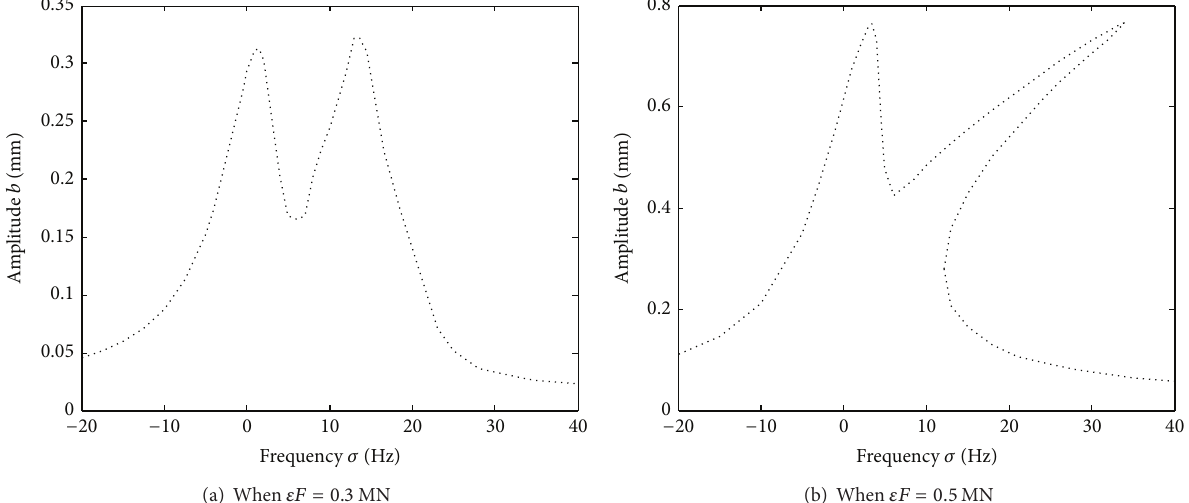
Figure 9: Curve of inner resonance amplitude frequency in vertical direction with disturb amplitude 𝜀𝐹 .